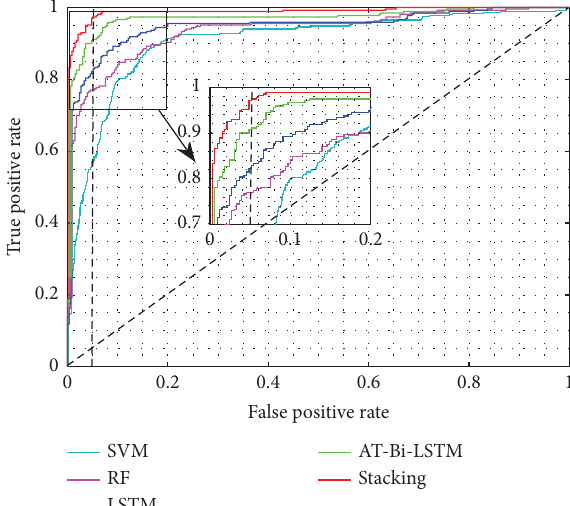
Figure 15: ROC curves of diferent models at 0.5s before crossing the zebra